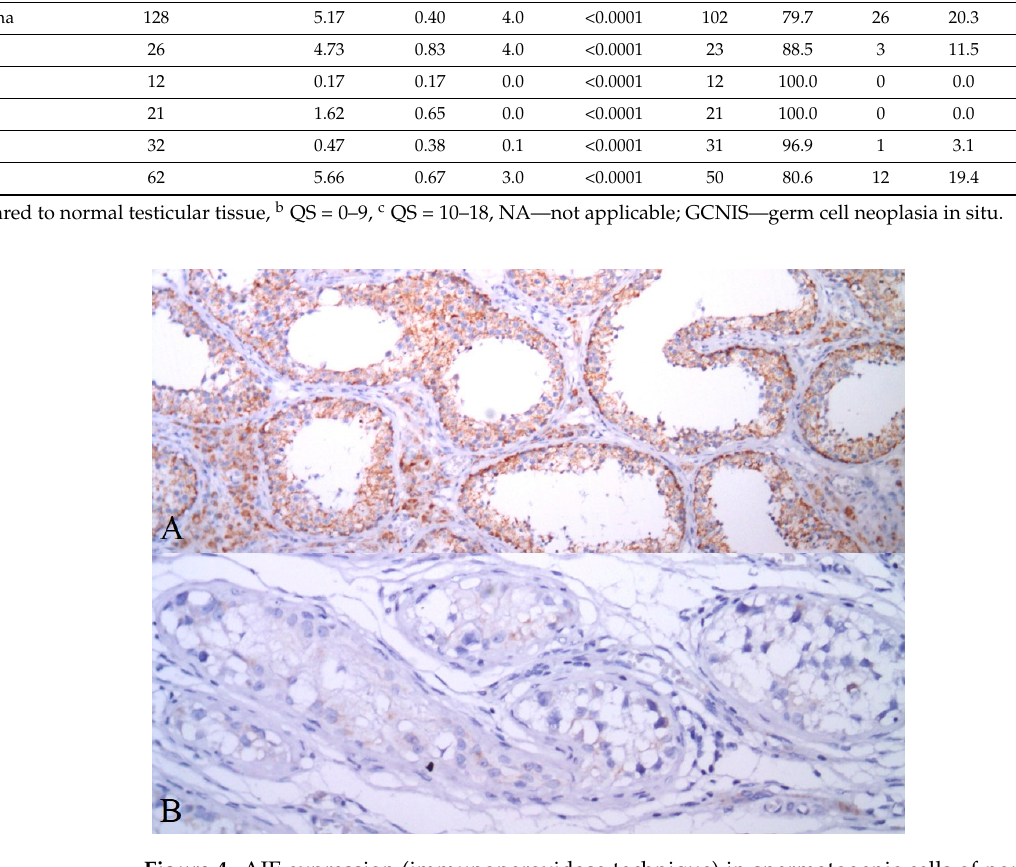
Figure 5. AIF expression in in spermatogenic cells of noncancerous testicular tissue (*) and in GCNIS (arrows) (immun- operoxidase technique, 200×).